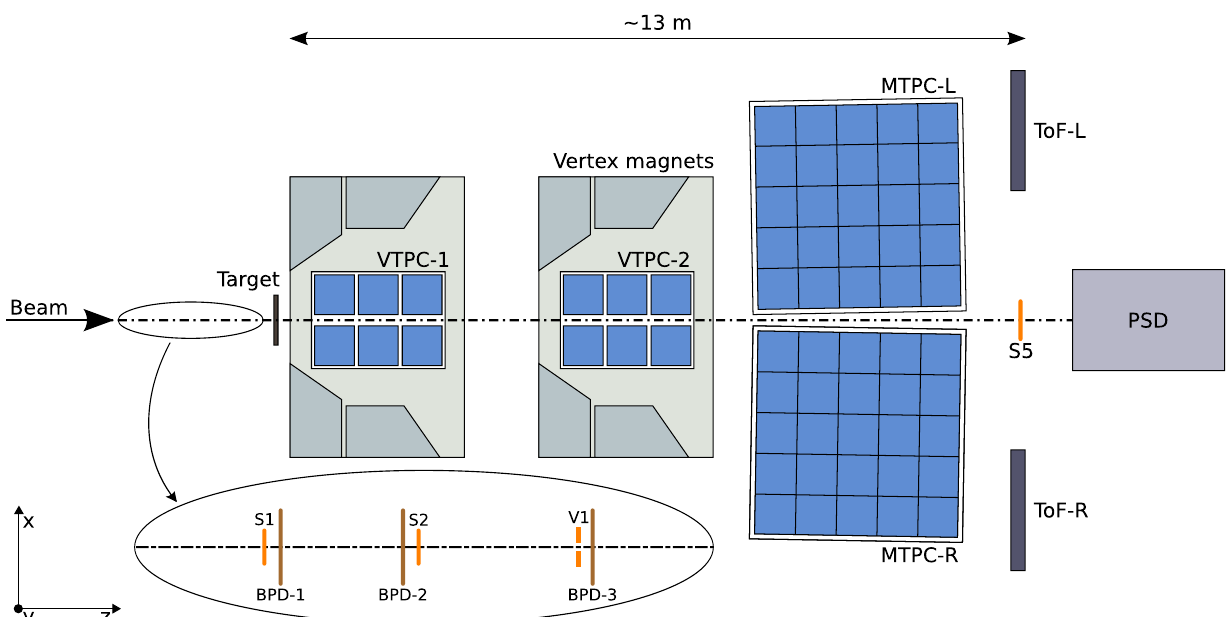
Fig. 1 The schematic layout of the NA61/SHINE experiment at the CERN SPS [1] showing the components used for the Ar+Sc energy scan (horizontal cut, not to scale). The trigger detector configuration upstream of the target is shown in the inset. Alignment of the chosen coordinate system is shown on the plot; its origin lies in the middle of